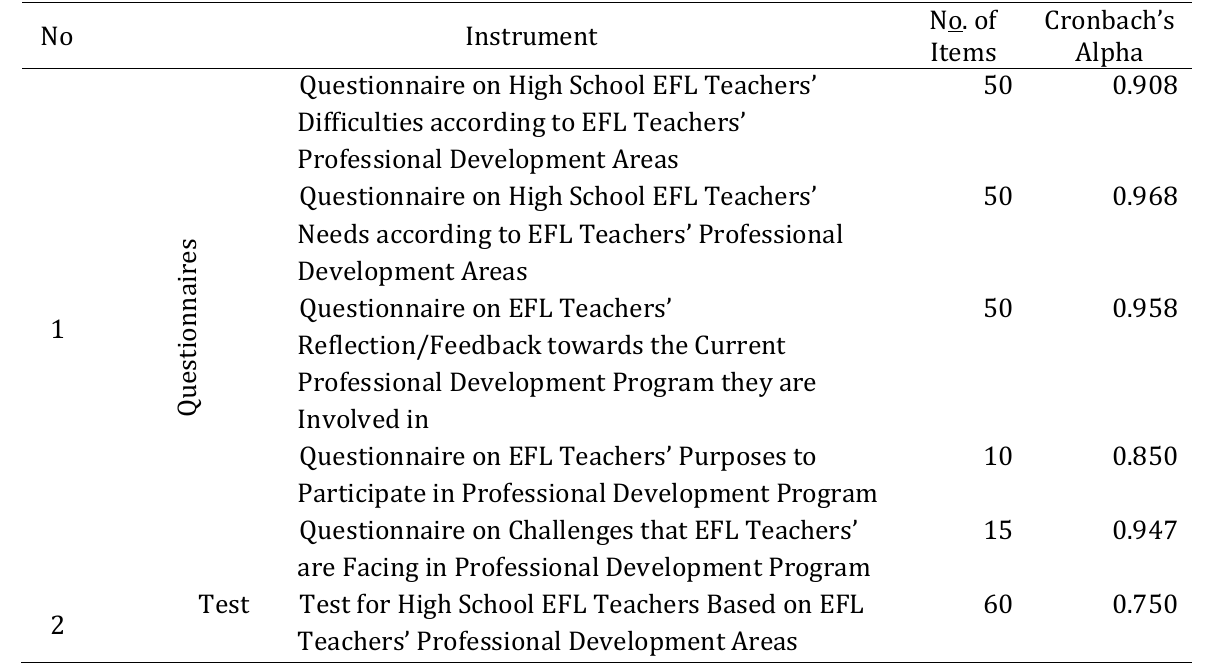
Table 1. Instruments